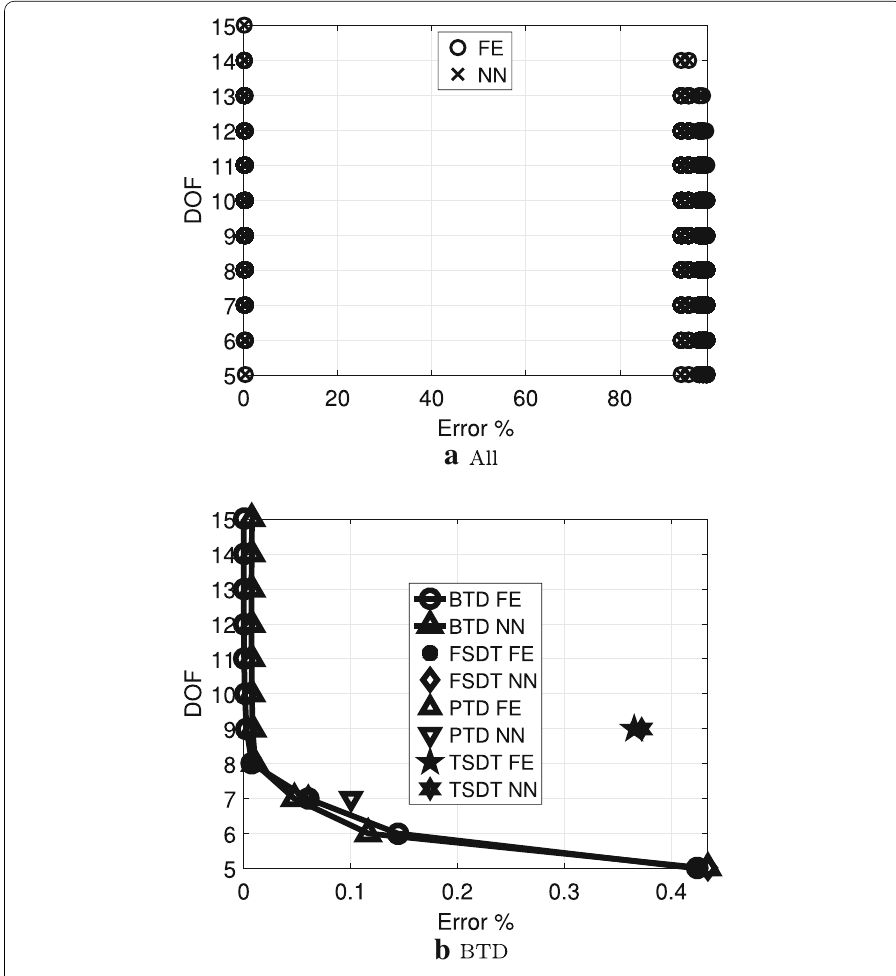
Fig. 7 FE and NN results for 0/90/0, a/h = 100, one layer with ten neurons